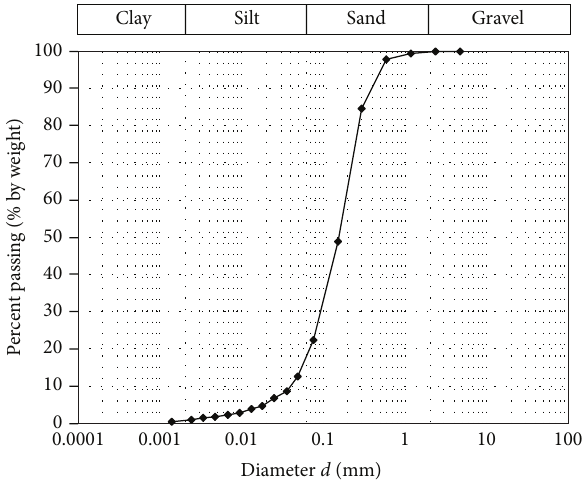
Figure 2: Typical grain size distribution curve (sample number 14 with midpoint depth equal to 47.45 m on the drilling column of the piezometer